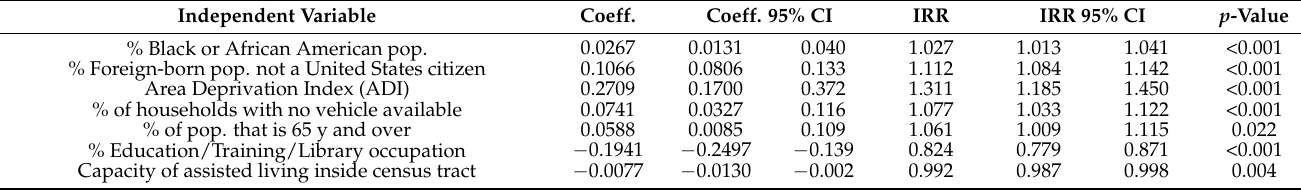
Table 4. Across-domains multivariable relationships between neighborhood characteristics and the community incidence of